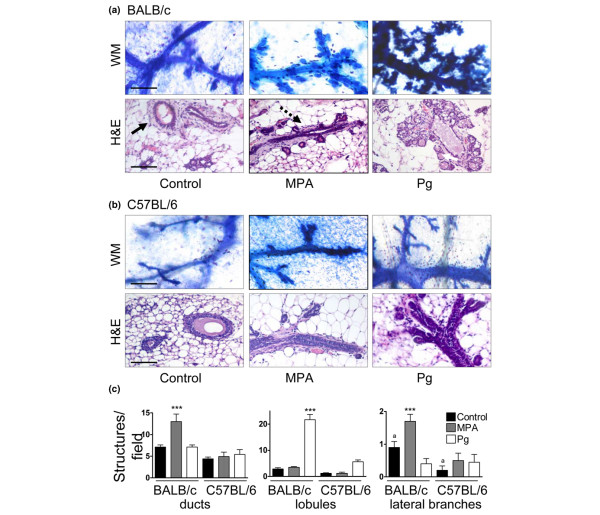
Mammary glands from progestin-treated mice. MPA (40 mg), Pg (40 mg), or control blank silastic pellets were implanted subcutaneously in 2-month-old (a) BALB/c or (b) C57BL/6 female mice. After 2 months, the mice were killed and the mammary glands processed for histological evaluation (H&E) or for WM (as described in the Materials and methods section). A representative image observed in at least four different mice of each group is presented. The numbers of ducts (black arrow), lobules (white arrow), and lateral branching (dotted arrow) were (c) quantified in each H&E stained slide and expressed as the number of structures per 400× field. MPA treatment induced an increase in the number of ducts and in lateral branching only in BALB/c mice, whereas Pg induced an increase in the number of lobules mainly in BALB/c. In control groups, animals were euthanized at diestrus. ***P < 0.001, treated versus control; aP < 0.05 between controls of both strains. Magnification: 100×, bar: 100 μm. H&E, hematoxylin and eosin; MPA, medroxyprogesterone acetate; Pg, progesterone; WM, whole mount.